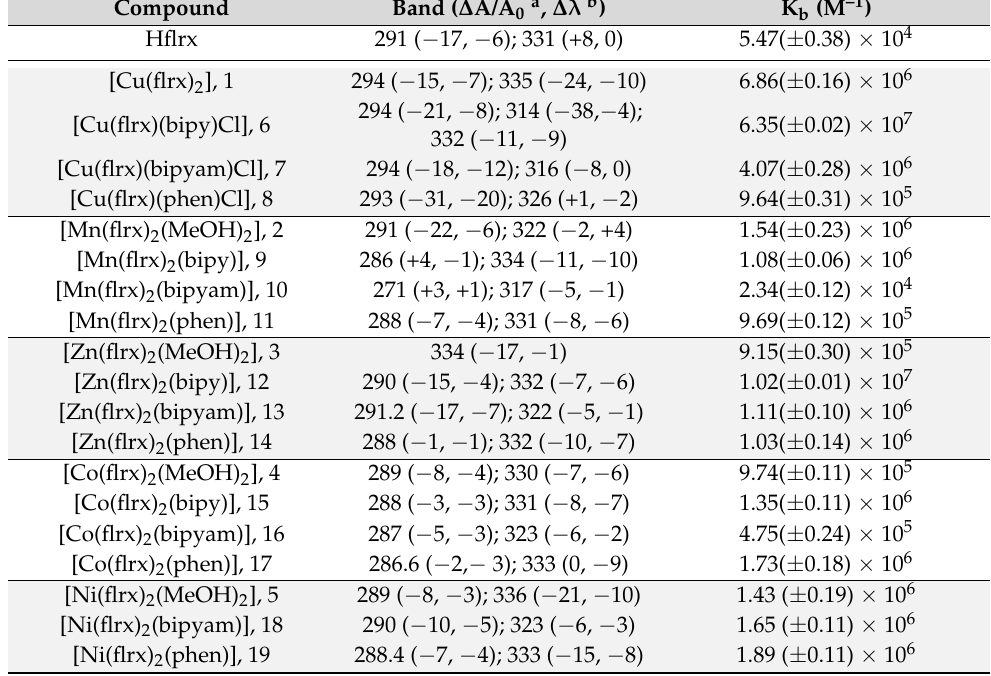
Figure 6. UV–vis spectra of DMSO solution of complex 16 (5 × 10 − 5 M) in the presence of increasing amounts of CT DNA. The arrows show the changes upon addition of increasing amounts of CT DNA. Table 6. Spectral features of the UV–vis spectra of fleroxacin and its complexes 1 – 19 upon addition of DNA. UV–vis band ( λ max , in nm) (percentage of hyper-/hypochromism ( ∆ A/A 0 , in %), blue/red shift of the λ max ( ∆ λ , in nm) and the corresponding DNA-binding constants (K b , in M − 1 ).